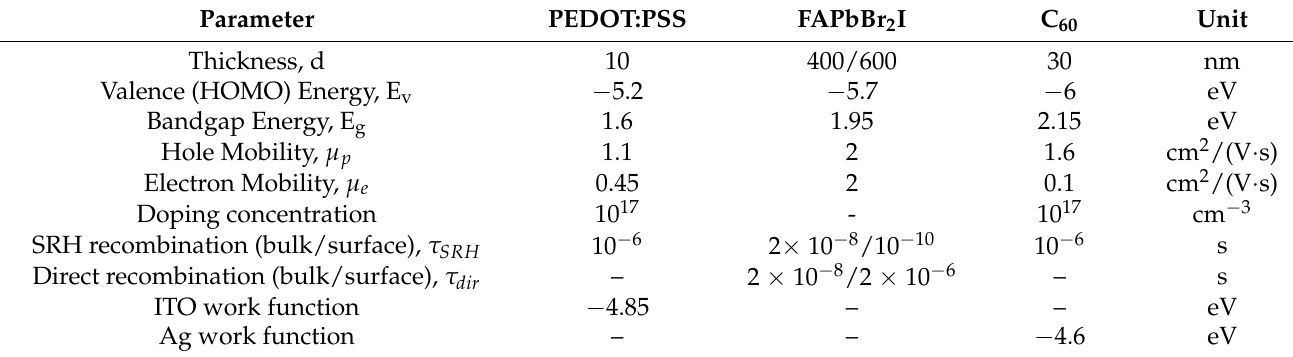
Table 1. Verified materials parameters of light-emitting solar cell (LESC) used in electrical simulations. Parameter